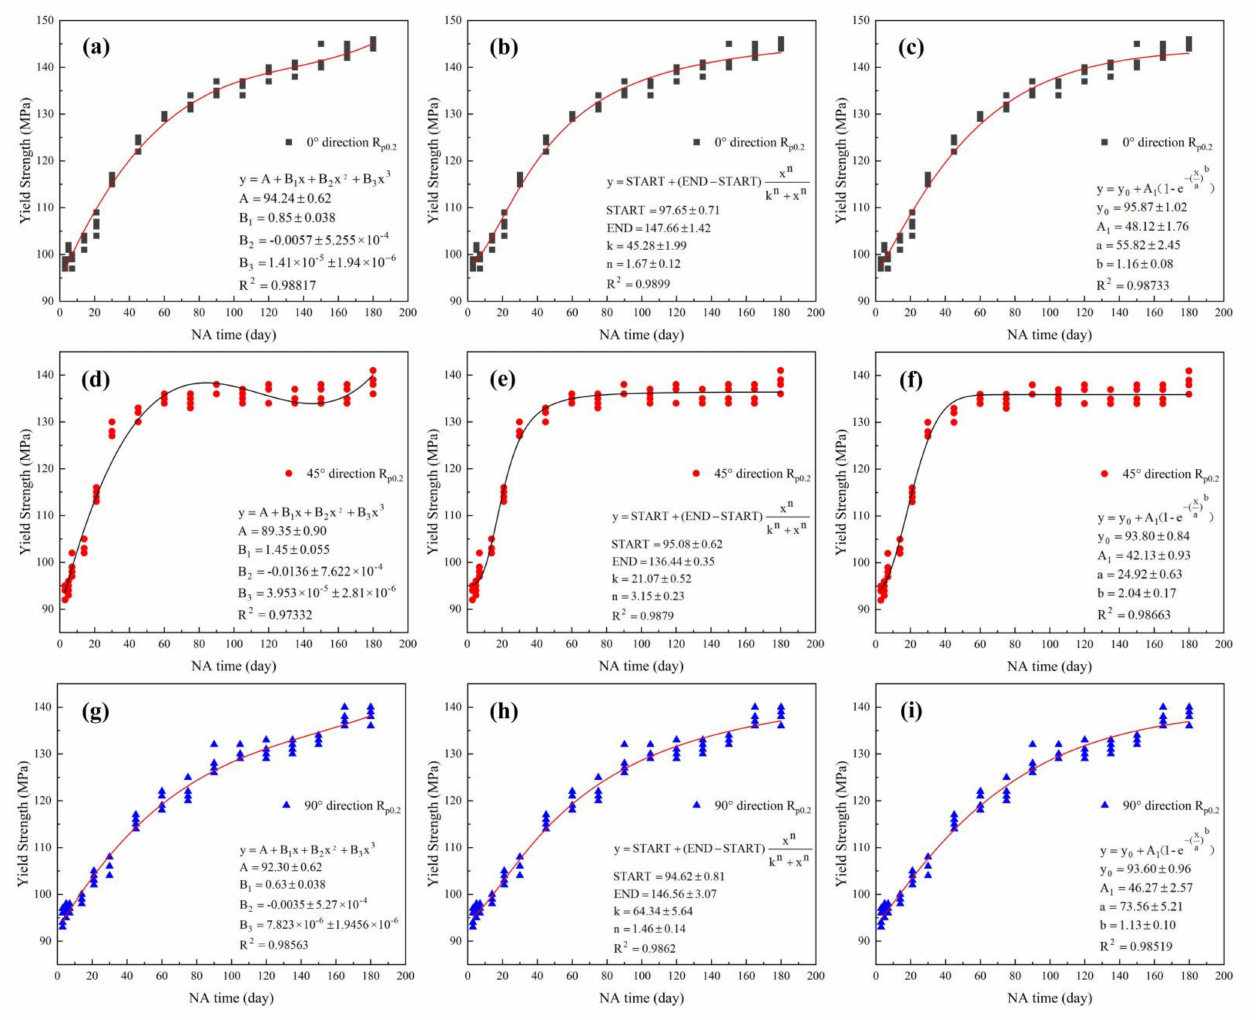
Figure 16. Fitting diagram of R p0.2 along 0 ◦ ( a – c ), 45 ◦ ( d – f ), and 90 ◦ ( g – i )